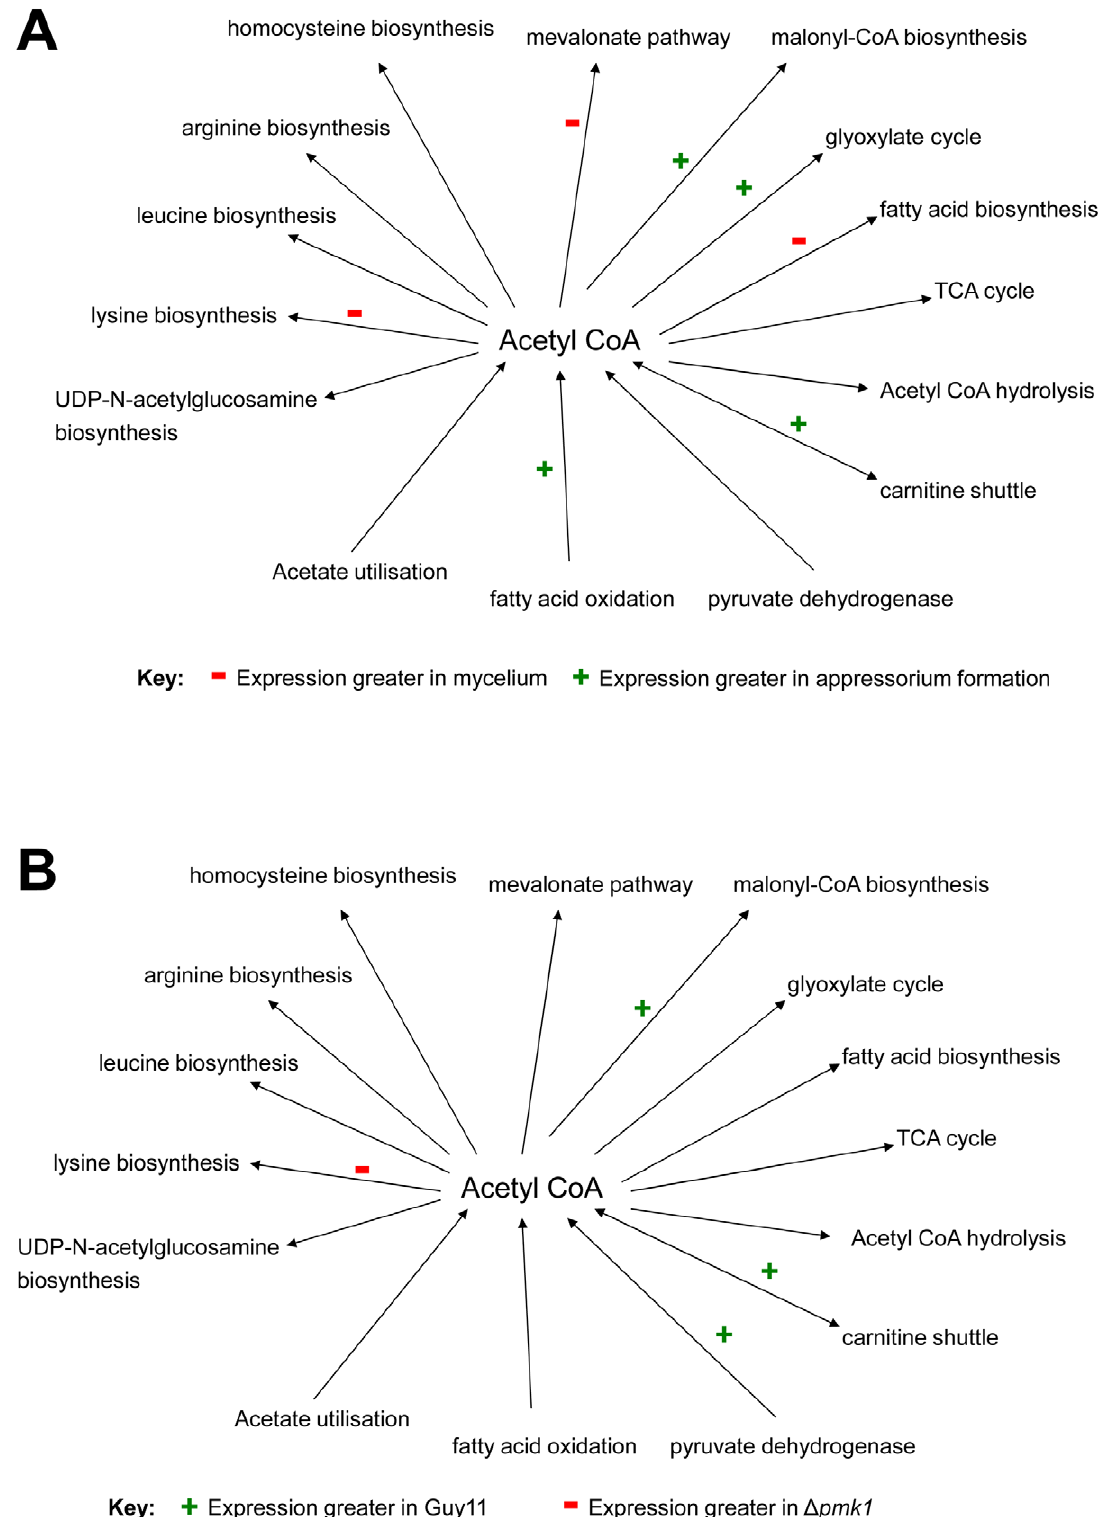
Figure 2. Expression level of genes encoding enzymes that produce or utilise acetyl-CoA. The diagrams illustrate metabolic pathways that produce (arrow pointing towards acetyl-CoA) or utilise (arrow pointing away from acetyl-CoA) acetyl-CoA. Transcript abundance was compared in those genes from each pathway that encode enzymes that directly utilise or produce acetyl-CoA A . Guy11 germinating conidia (4 h) and Guy11 mycelium grown in complete medium. B . D pmk1 germinating conidia (4 h) and Guy11 germinating conidia (4 h). The diagrams also show which pathways contain genes significantly more highly expressed in one condition as compared to the other (see key for each diagram). These are based on adjusted P-value , =0.05 for at least one of the genes in each pathway. doi:10.1371/journal.ppat.1002514.g002 PLoS Pathogens |